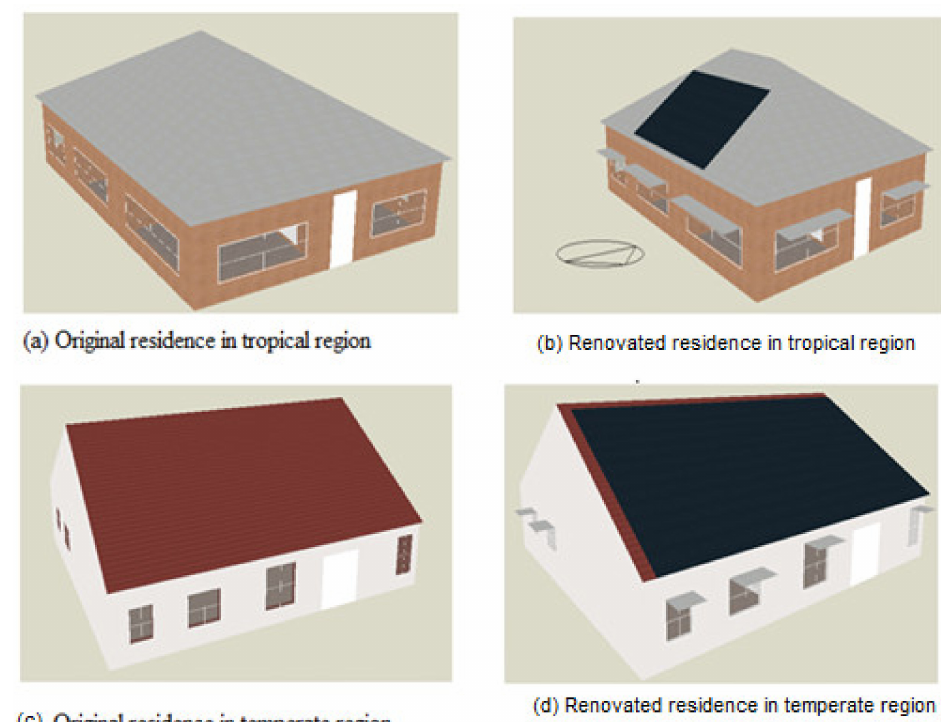
Figure 4. Case of ( a , b ) renovated residence building in the tropical region and ( c , d ) temperate climate.